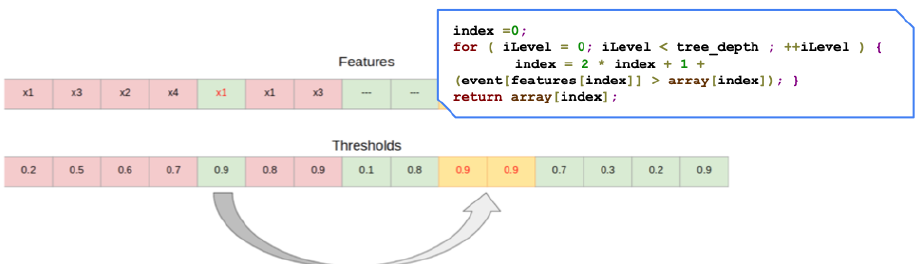
Fig. 2. Demonstration of the process that fills a sparse tree into a full tree and its corresponding array representation. On the top right is the code snippet for traversing the array representation of the